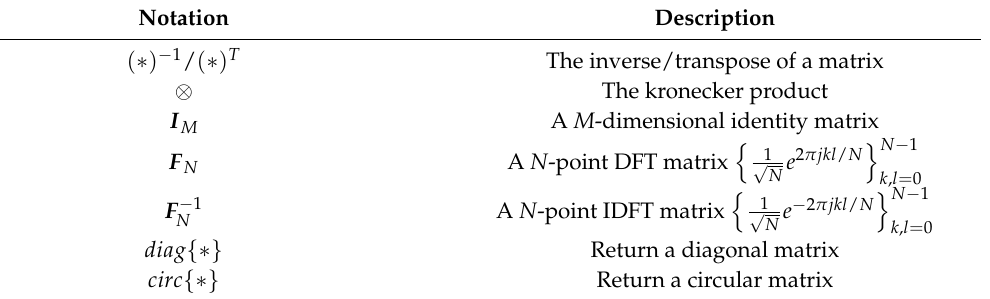
Table 1. Mathematical notation.